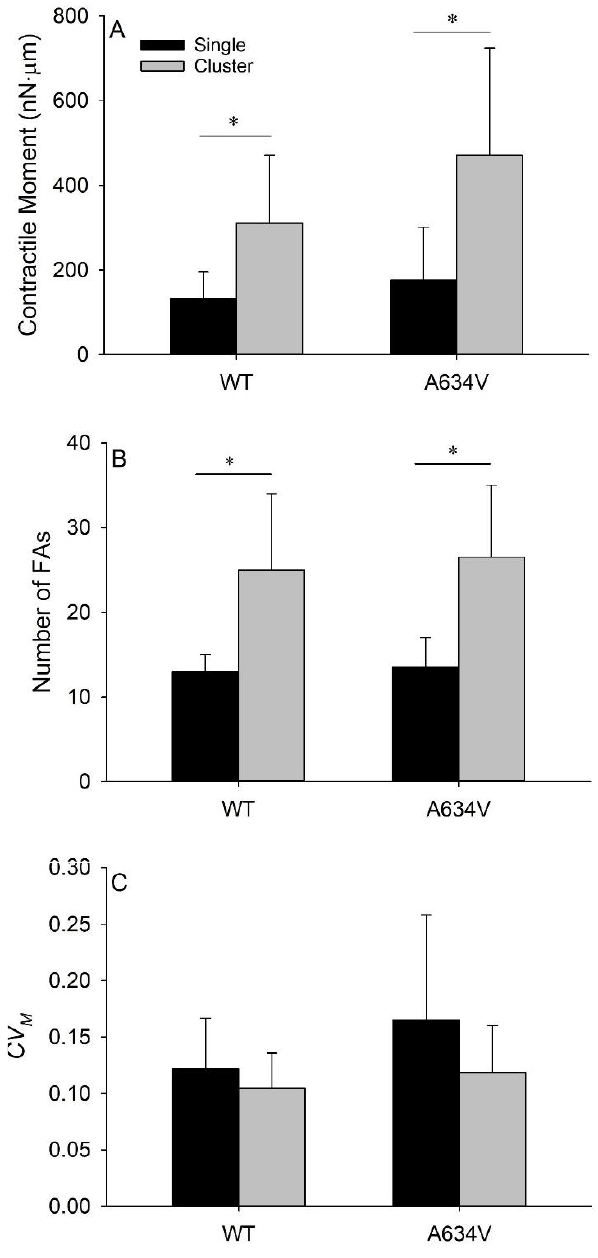
Figure 7. Tensional homeostasis in single cells and in cell clusters. Comparison of the median values of the time-averaged contractile moments ( A ); of the median numbers of focal adhesions (FAs) ( B ); and of the median values of the coefficient of variation of the contractile moment ( CV M ) ( C ) of single WT and A634V cells (black bars), and the corresponding clusters of cells (gray bars) cultured on the combination of Fibronectin and Vitronectin micropatterns. Clusters exhibit significantly higher values of the contractile moment and of the number of FAs than the single cells. No significant differences in the median values of CV M between single cells and clusters are observed. No significant differences in the median values of the contractile moment, the number of FAs, and CV M between WT single cells/cluster and A634V single cells/clusters are observed. The graph bars represent median values ± MAD; * significantly different contractile moment and number of FAs ( p < 0.05).